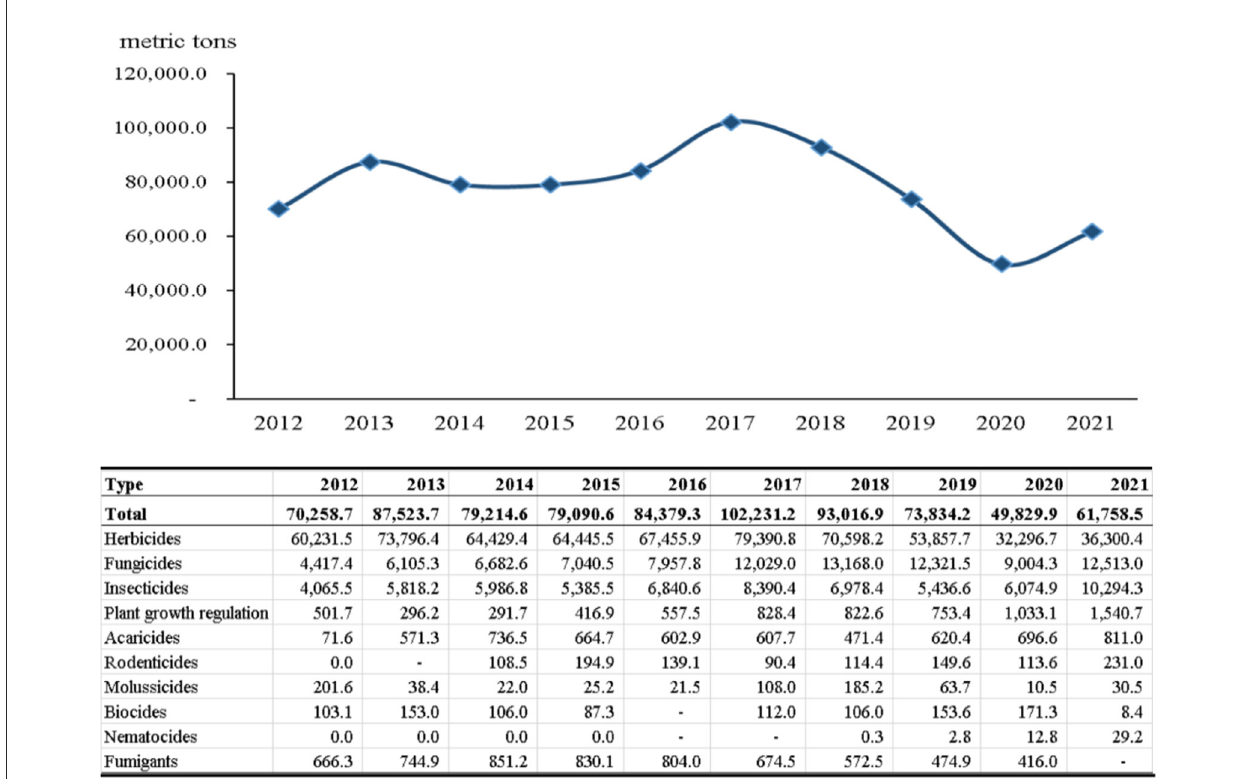
FIGURE1 The amounts of pesticides imported into Thailand from 2012 to 2021.